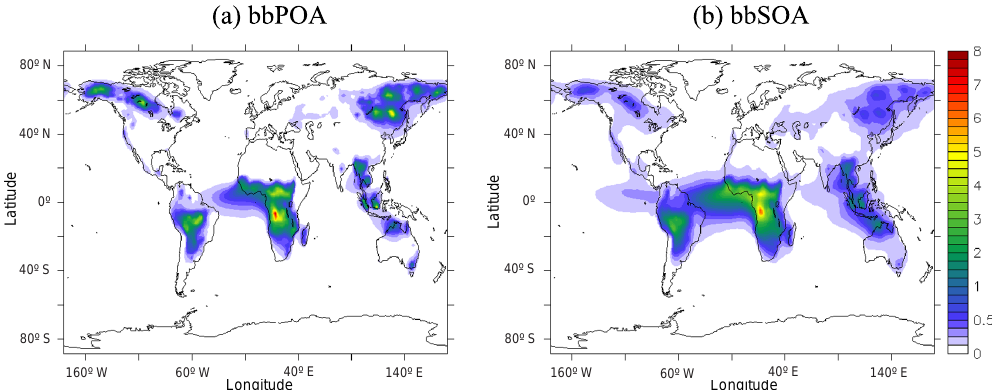
Figure 7. Predicted average surface concentrations (in µgm − 3 ) of (a) POA from biomass burning sources (bbPOA) and (b) SOA from the oxidation of SVOCs and IVOCs from biomass burning sources (bbSOA) during the years 2001–2010.